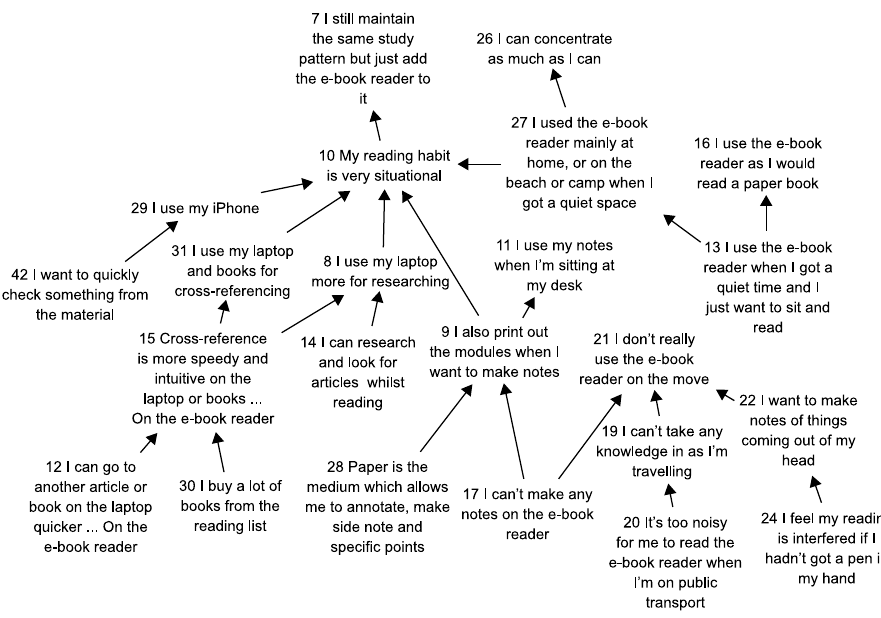
Figure 4. Situational